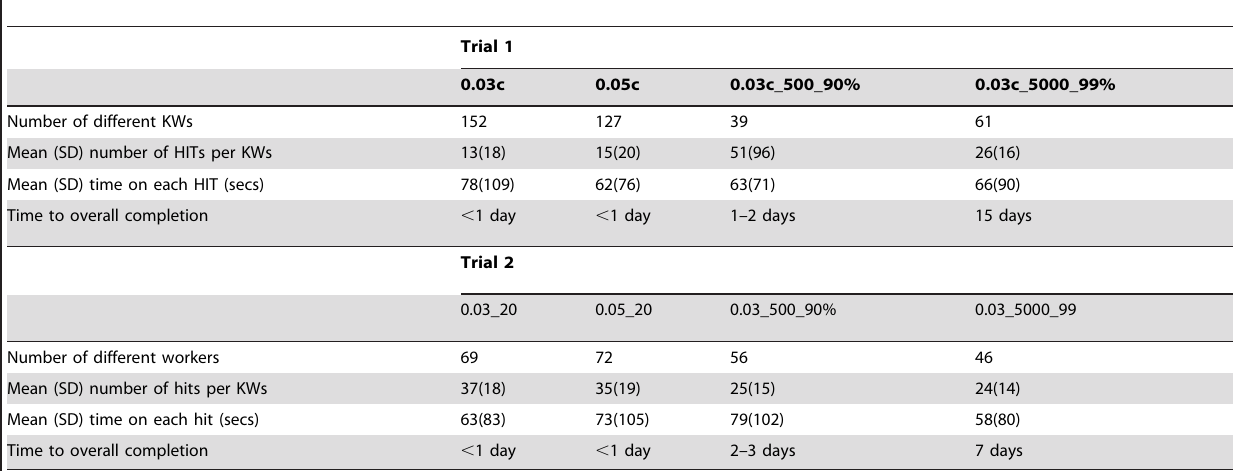
Table 1. Baseline characteristics of KW participation by study design for trials 1 and